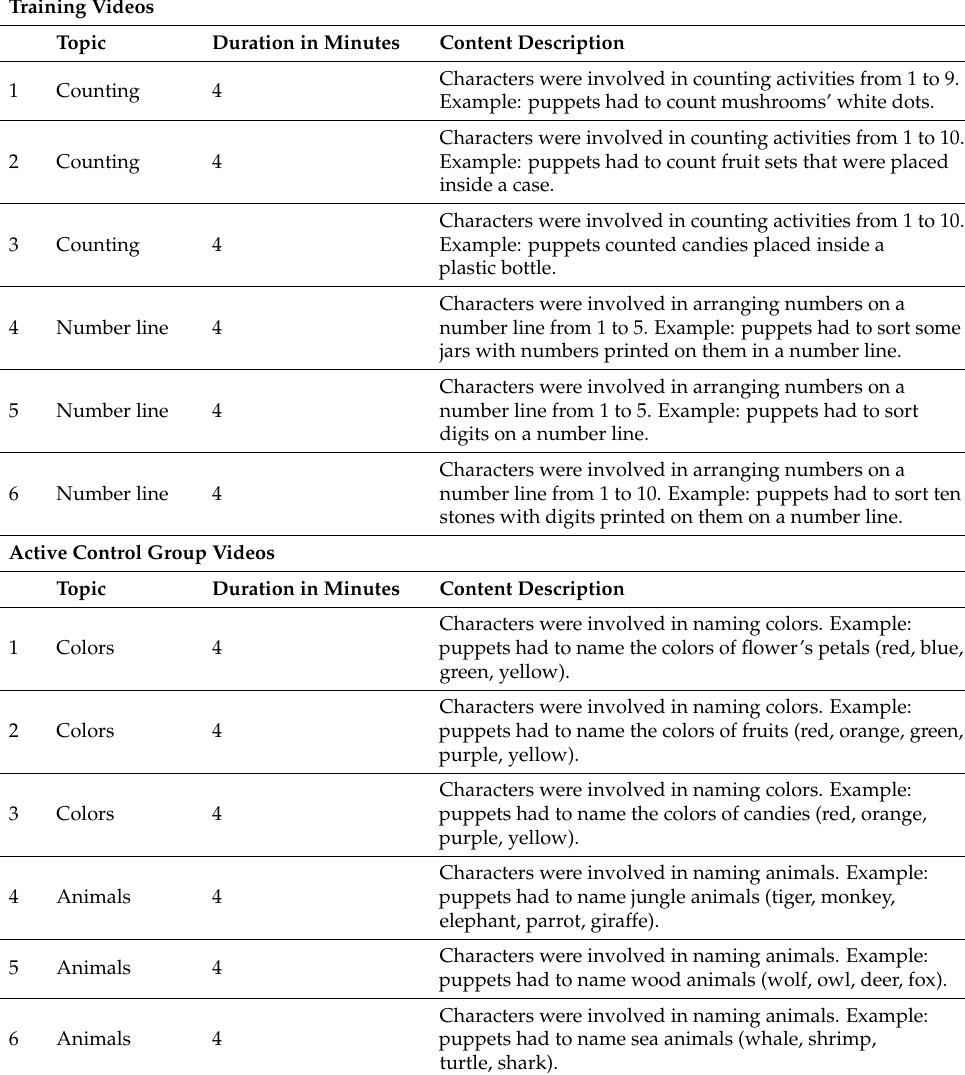
Table 1. Topic, duration in minutes and content description of the training